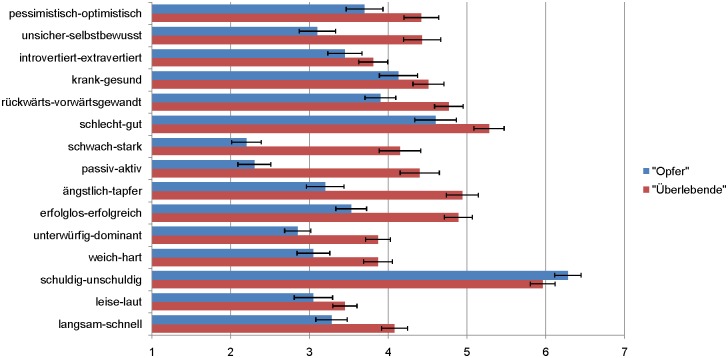
Means of semantic differential ratings by label condition (Study 1, German-language sample, n = 93).Error bars represent standard errors.